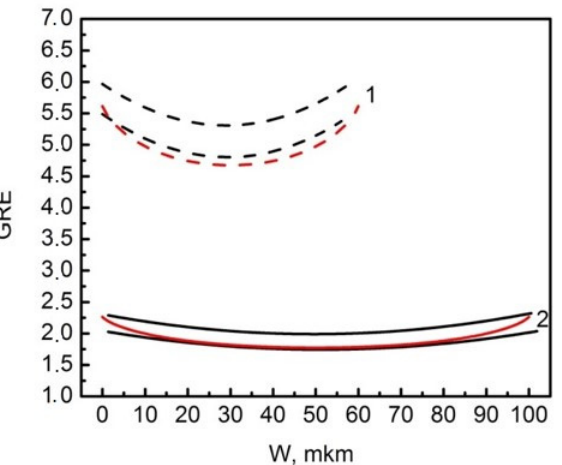
Figure 3. GRE profiles across the window for GaAs SAE-L-N (1) and SAE-L-W (2) samples grown by the SAE technique at the same growth reactor parameters corresponding to a growth rate of 18.8 nm/min for the St-L-L sample.